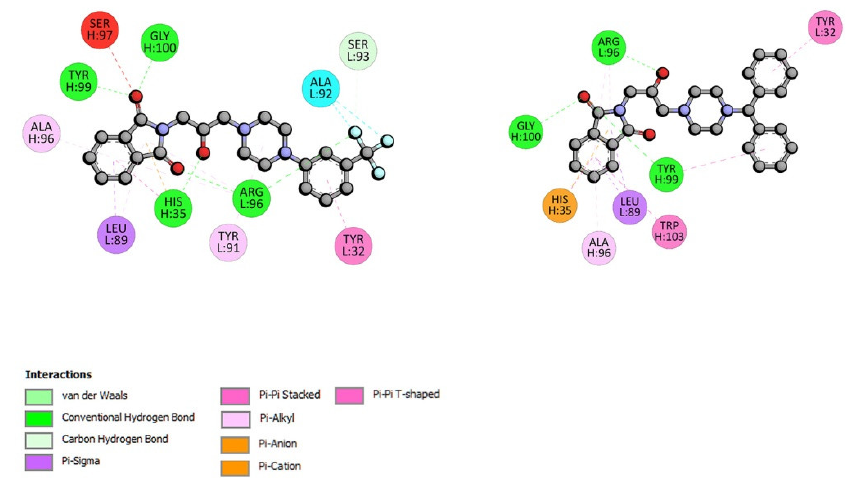
Figure 12. The 2D interaction plots of compounds F1–F4 with